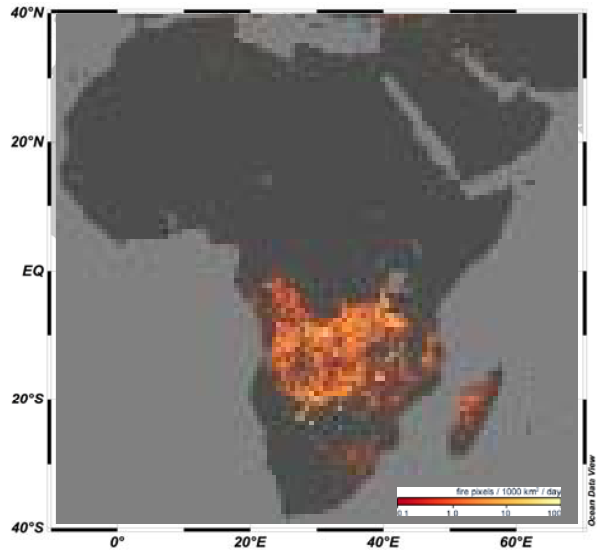
Fig. 11. Biomass-burning active fire spots detected by MODIS satellite images (from NASA website) over southern and eastern Africa and Madagascar in July